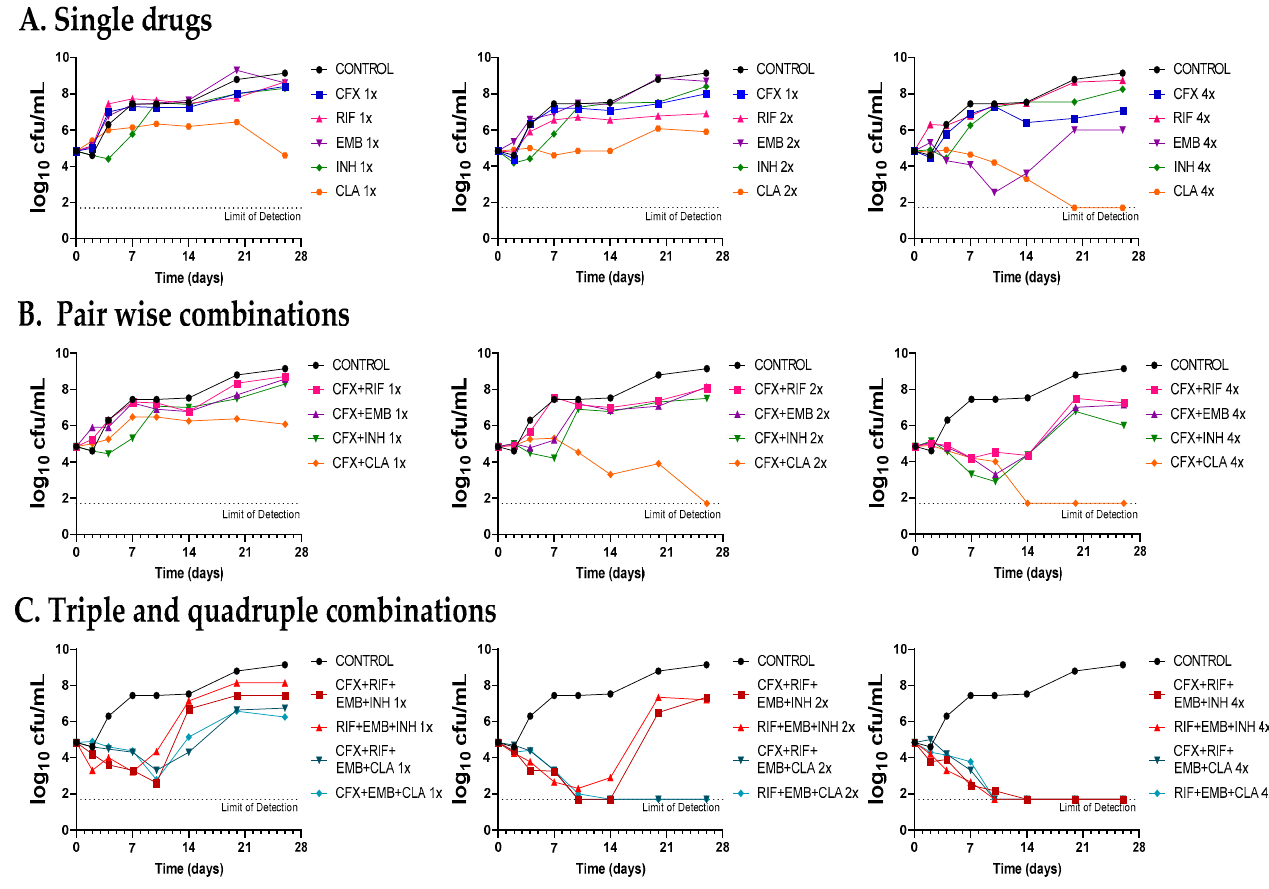
Figure 5. Time-kill assays of cefadroxil in combination with standard therapies against Mkn ATCC 12478. ( A ) Single drugs. ( B ) Pairwise combinations of cefadroxil with either rifampicin, ethambutol, isoniazid or clarithromycin. ( C ) Standard triple therapies against Mkn and quadruple combinations including cefadroxil. Time-kill assays were performed in Middlebrook 7H9 broth plus ADC. MIC values used were: CFX: 8 mg/L; RIF: 0.125 mg/L; EMB: 4 mg/L; CLA: 0.25 mg/L and INH: 8 mg/L. A positive control with no antibiotics was included (CONTROL). Data represent one experiment of at least two independent experiments performed in duplicate. CFX: cefadroxil; RIF: rifampicin, EMB: ethambutol, INH: isoniazid, CLA: clarithromycin.